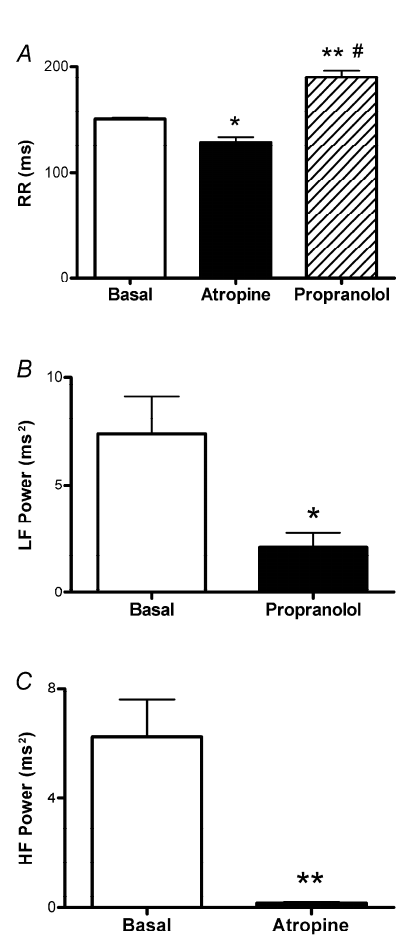
Fig. 3 – Autonomic blockade data: A – Mean RR values under basal conditions and after atropine (2 mg kg − 1 ) or propranolol (4 mg kg − 1 ) blockade. B – Low-frequency spectral power under basal conditions and after propranolol blockade. C – High-frequency spectral power under basal conditions and after atropine blockade. Data expressed as mean ± SEM. *p < 0.05 vs. basal; **p < 0.001 vs. basal; #p < 0.001 vs. atropine. For all conditions, n =